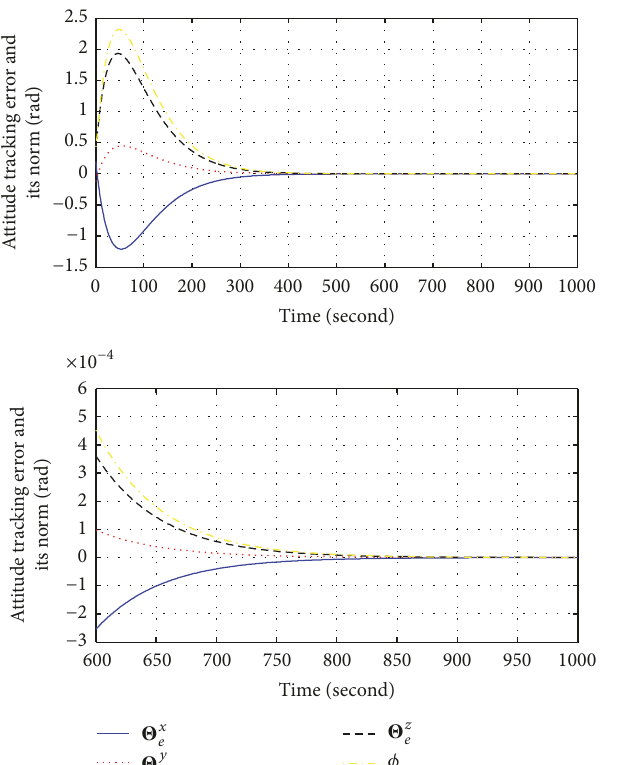
Figure 3: Exponential coordinates of position tracking error and its norm.